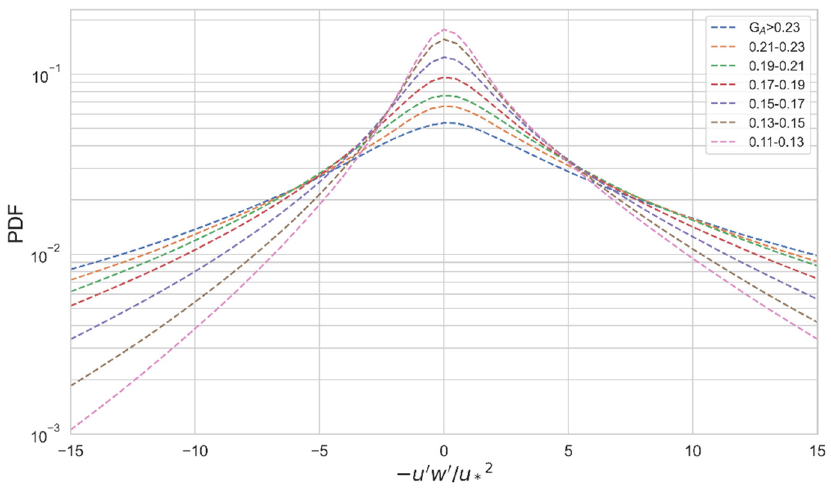
Figure 12. Probability density functions of − u (cid:48) w (cid:48) / u 2 ∗ as a function of wind gustiness, G A .